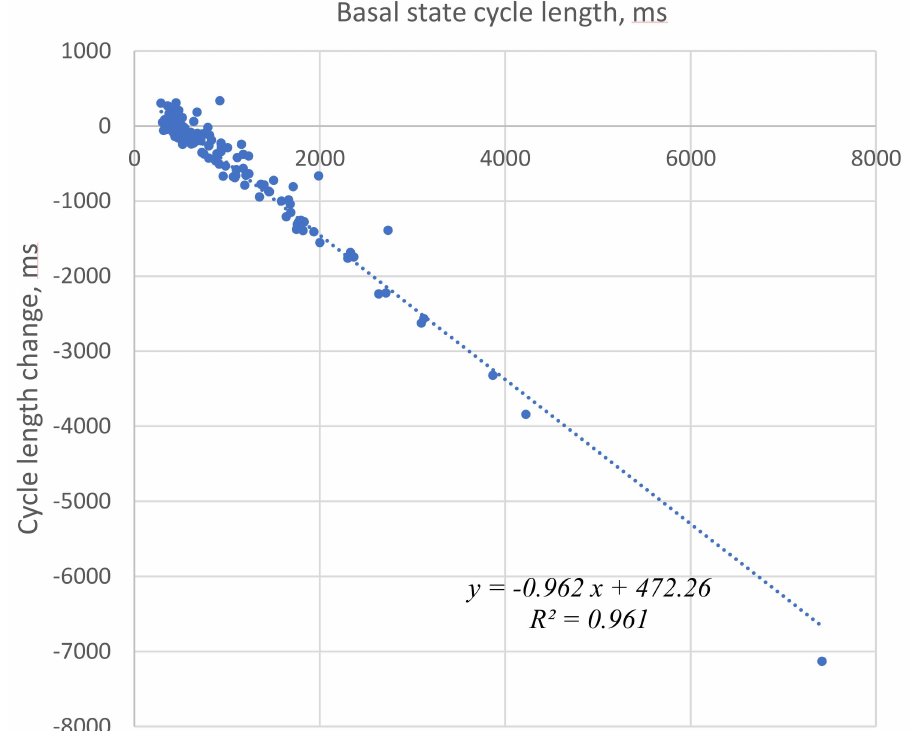
Figure 3. Strong correlation of the initial cycle length (basal state) with a change in the cycle length in the presence of β AR stimulation. Negative numbers on the Y axis represent cycle length decrease, i.e., rate